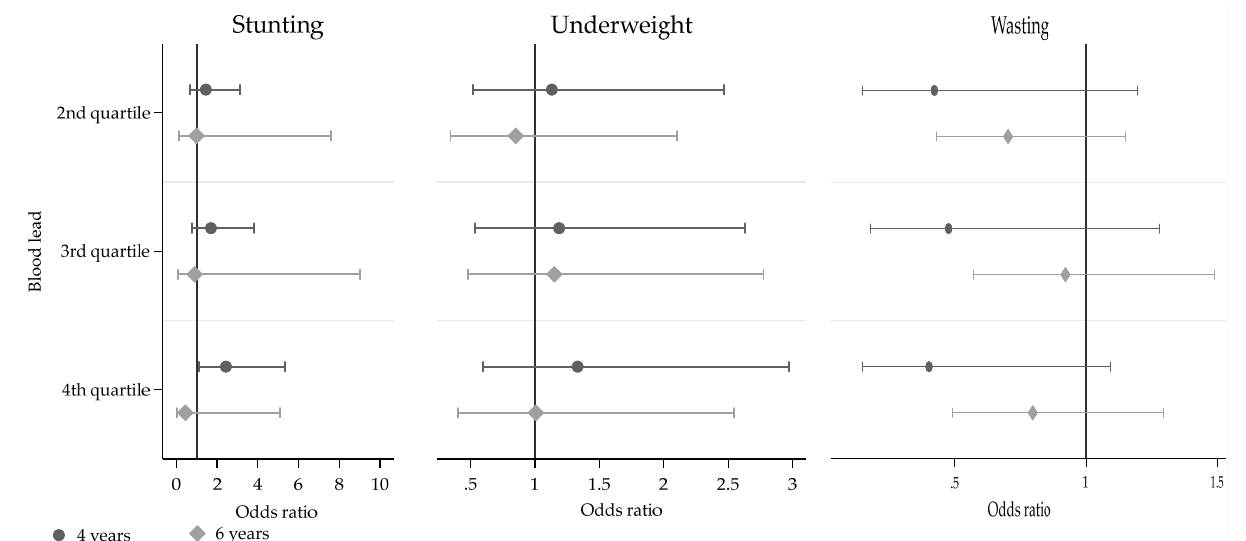
Figure 1. Adjusted odds ratio (OR) a and 95% confidence intervals for the associations between blood lead level quartiles* at age 1 year and stunting a , wasting b , and underweight c at age 4 (black shade) and 6 years (grey shade) in Beninese children (Allada cohort). P- trend for stunting † (4 years: 0.03, 6 years: 0.51). *1st quartile (not shown) is the reference category. a adjusted for maternal characteristics (education, material possession/wealth score, estimated pre-conceptional BMI) and child characteristics (sex, low birth weight, weight, and iron deficiency at age 1). N for models of 4 and 6 years: 422 and 345, respectively. b adjusted for maternal characteristics (education, material possession/wealth score, estimated pre-conceptional BMI) and child characteristics (sex, low birth weight, and iron deficiency at age 1). N for models of 4 and 6 years: 553 and 614, respectively. c adjusted for maternal characteristics (education, material possession/wealth score, estimated pre-conceptional BMI) and child characteristics (sex, low birth weight, height, and iron deficiency at age 1). N for models of 4 and 6 years: 419 and 41, respectively. † P trends across quartiles of Pb were obtained by inserting its quartile as a continuous variable in the regression model.